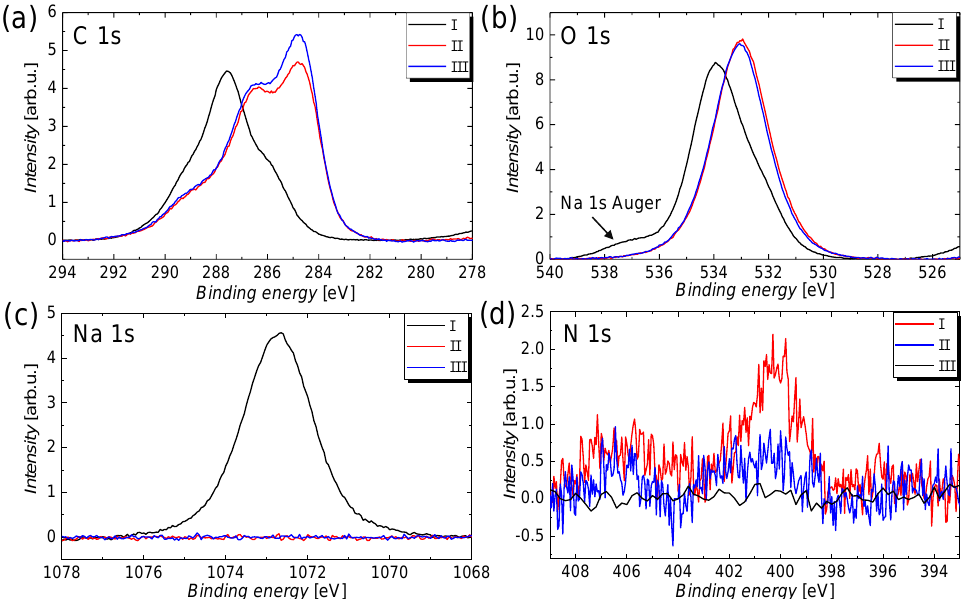
Figure 2. High-resolution spectra for the different treatments and the core-level spectra ( a ) C 1s, ( b ) O 1s, ( c ) Na 1s, as well as ( d ) N 1s. The spectra are normalized with respect to the concentrations of the specific elements. Table 1. Relative elemental composition of the carboxymethyl cellulose (CMC)-carbon nanotube (CNT) films for different post-treatments. The compositions were determined via X-ray photoelectron spectroscopy (XPS) and considering the relative sensitivity factors for the different peaks. The details for the treatments can be found in the main text.